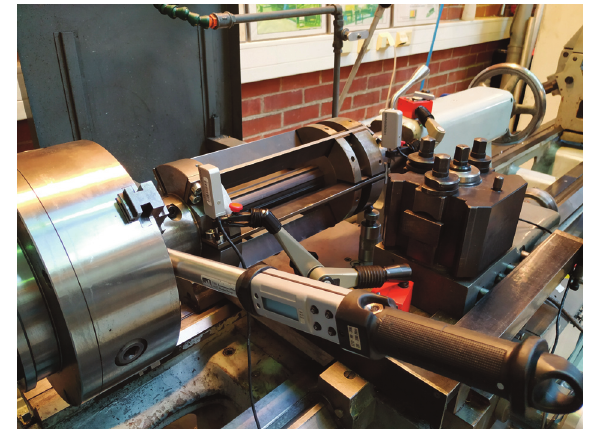
Fig. 4. The coupling in the test bench. The input half is attached to the lathe chuck, which allows rotation in torsional direction. The output half is fixed by attaching it to the lathe tailstock. Two displacement sensors are mounted to measure the displacement of the input end and to ensure that the fixed output end does not rotate. The torque is applied by placing weights to the torque wrench.